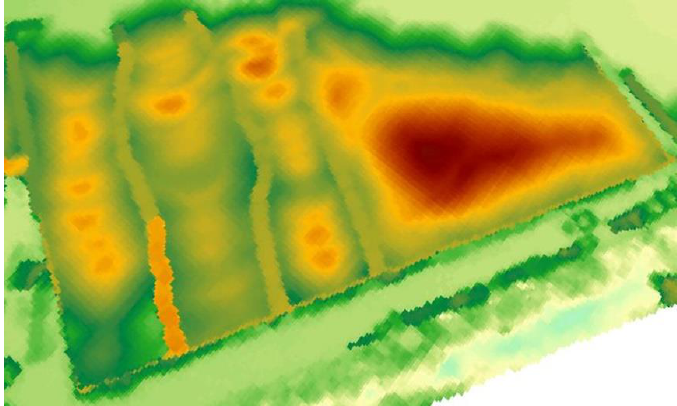
Figure 8. Raster DEM of the study area.